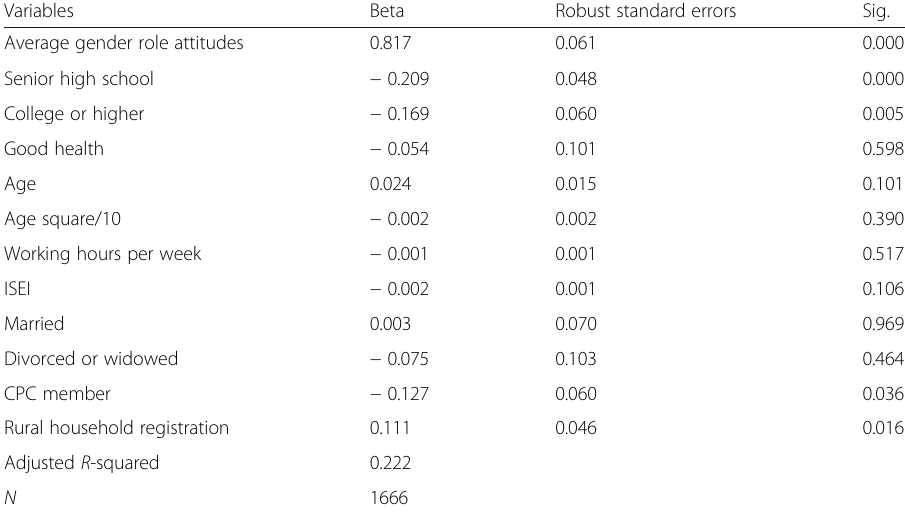
Table 3 First stage results for instrumental variable regression